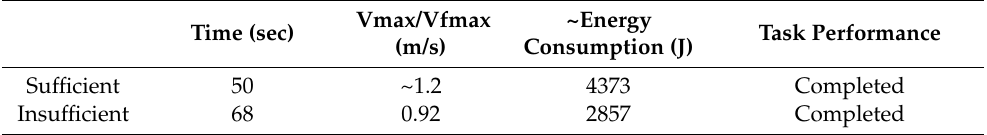
Table 7. Insufficient energy travel stability.